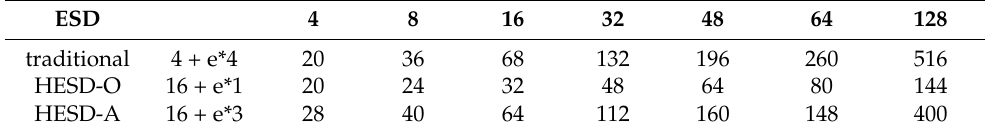
Table 2. The comparison of different electrodes required in various ESD designs.